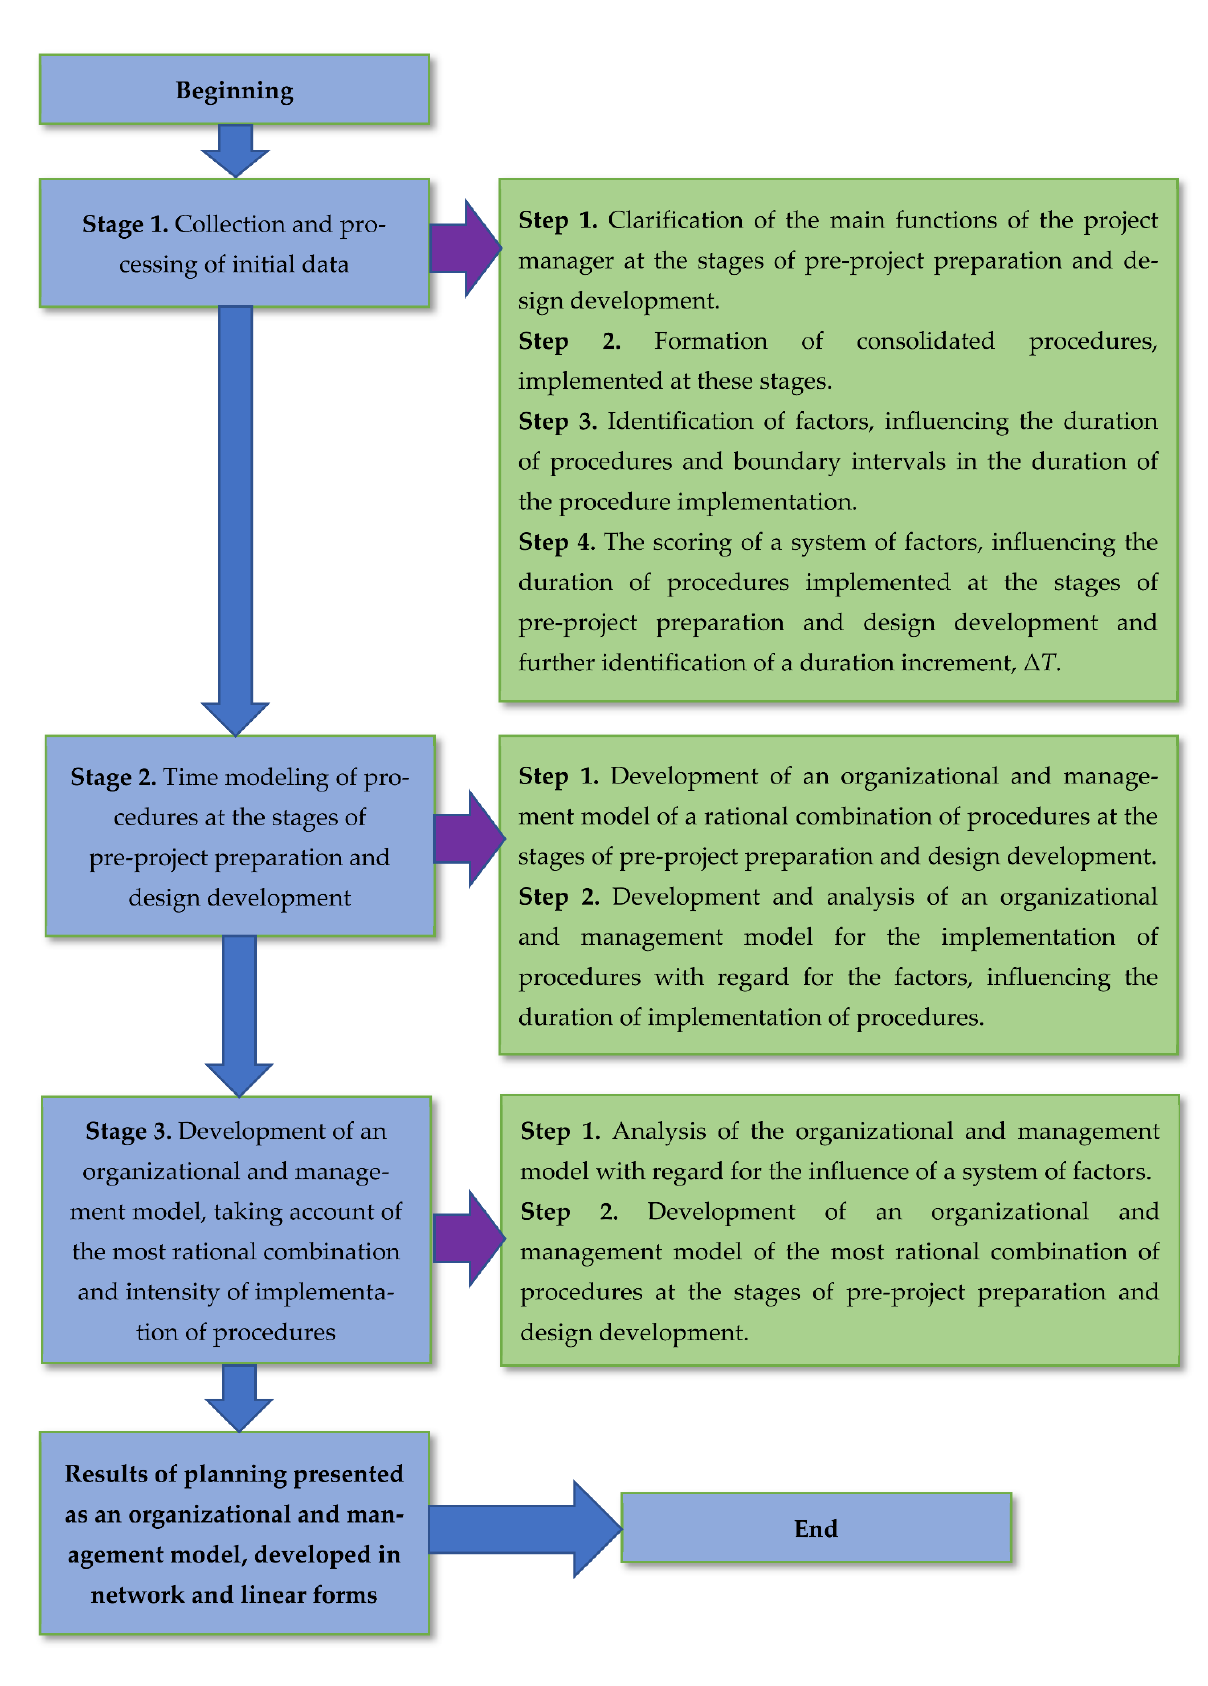
Figure 12. Selection of rational solutions at the stages of pre-project preparation and design development for the facilities to be constructed (stages and steps of the method).